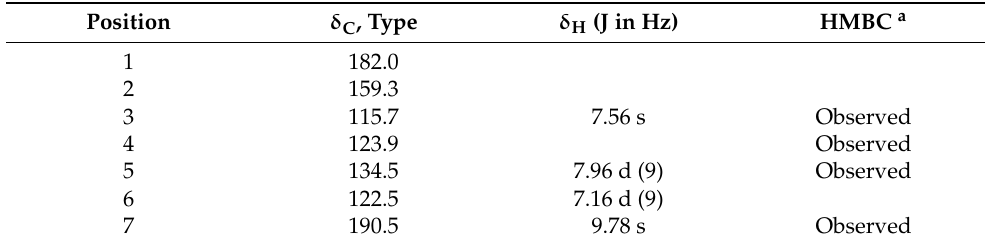
Table 2. NMR Spectroscopic Data (500 MHz, CD 3 CN) of the D 2 Compound.